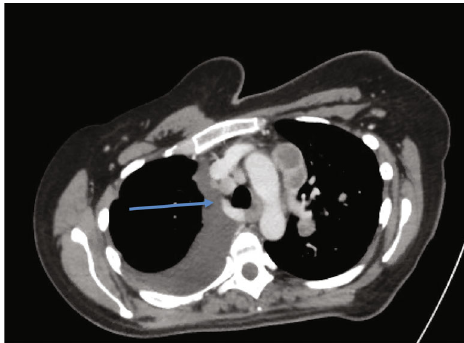
Figure 1: CT chest showing involvement of the right lower paratracheal lymphnodes (Station